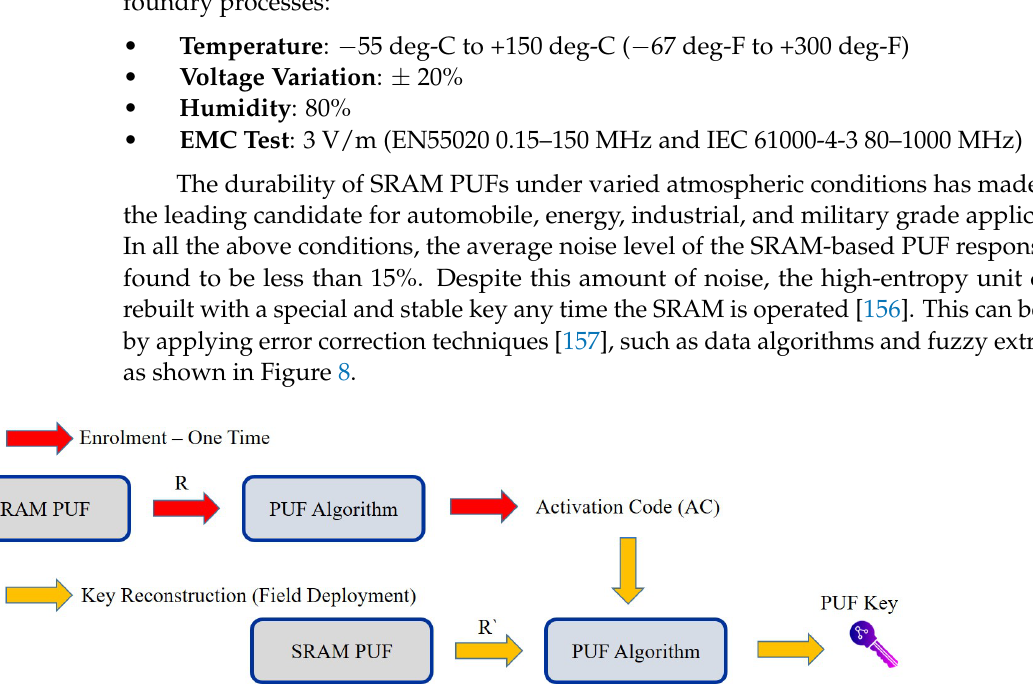
Figure 8. Enrolment and reconstruction phase for the generation of PUF keys. Note that R is the initial PUF response during enrolment, while R‘ is a PUF response in the field with a noise component and error